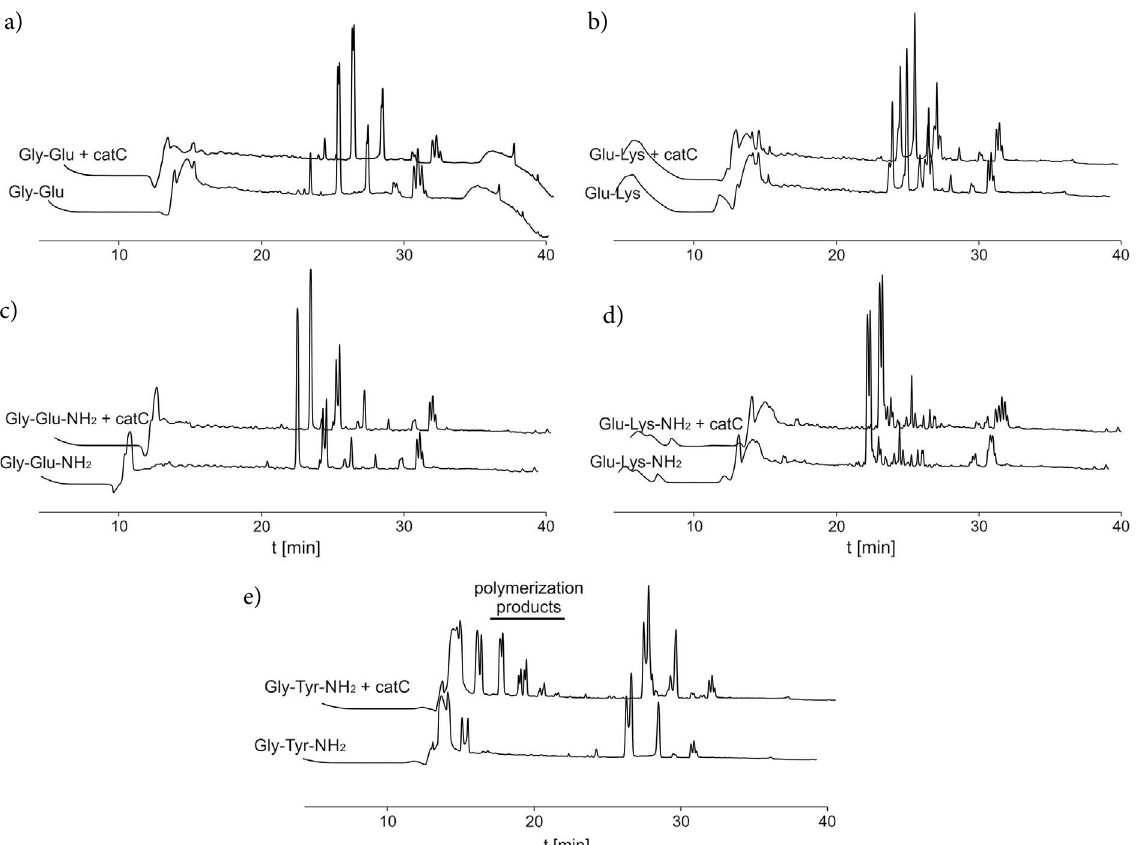
Figure 2. Dipeptides Gly-Glu, Glu-Lys or their amide forms are not polymerized by cathepsin C. Reverse phase HPLC using 0.1% pentafluoropro- pionic acid (PFPA) as anionic ion-pairing reagents for separation, following a four-hour reaction with cathepsin C, in comparison to the control samples (a) Gly-Glu, (b) Glu-Lys, (c) Gly-Glu-NH 2 , (d) Glu-Lys-NH 2 . (e) Polymerization of Gly-Tyr-NH 2 by cathepsin C as a control. For clarity purposes, the upper chromatograms are slightly